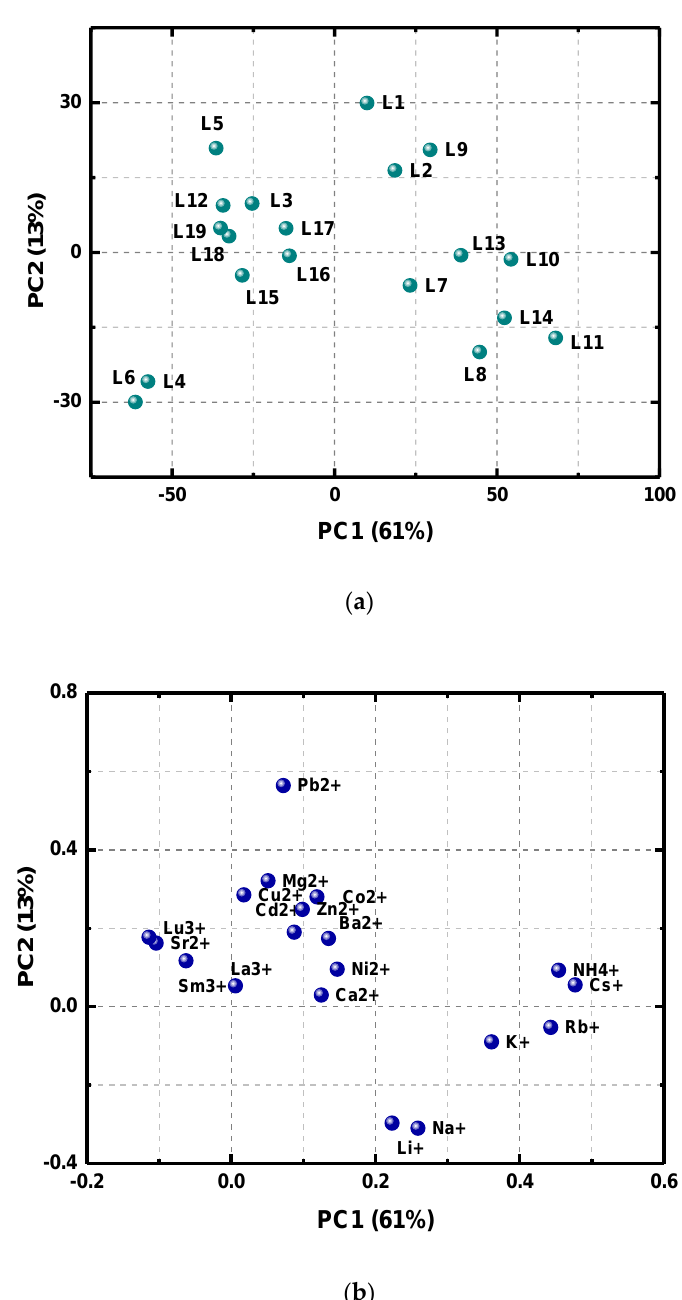
Figure 2. PCA scores ( a ) and loadings ( b ) plot for sensor sensitivities. The right-hand side of the PCA score plot is occupied by the sensors L10 , L11 , L14 that on average have shown the highest sensitivities towards all metals studied. In this way, L11 demonstrates near-Nernstian responses towards alkali and some of the transition metals (Co and Ni). Thus, the direction of PC1 in the score plot corresponds to the growth of the average sensitivity (from left to right). As for the PC2, the sensors which have the most different projection values on PC2 are L1 and L5 at the upper side, and again L4 and L6 at the bottom. L1 and L5 have shown the highest sensitivities towards Pb 2+ , in case of L1 this value has distinct super-Nernstian character (46 mV/dec). This is well visualized with the loadings plot (Figure 2b), where Pb has the highest loading values along PC2. The location of other variables in the loadings plot indicates that most differences in sensor responses were observed for alkali metals and ammonium, while the response